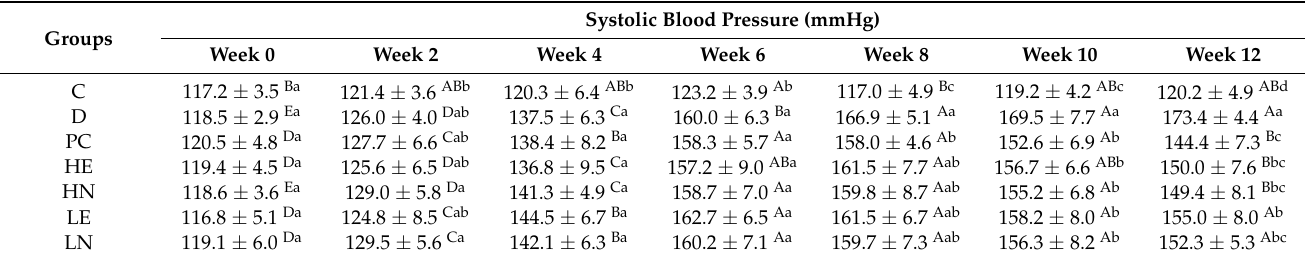
Table 2. Effect of the administration of black garlic extract and nanoemulsion on systolic blood pressure in DOCA-salt- induced hypertension and its associated mild cognitive impairment in